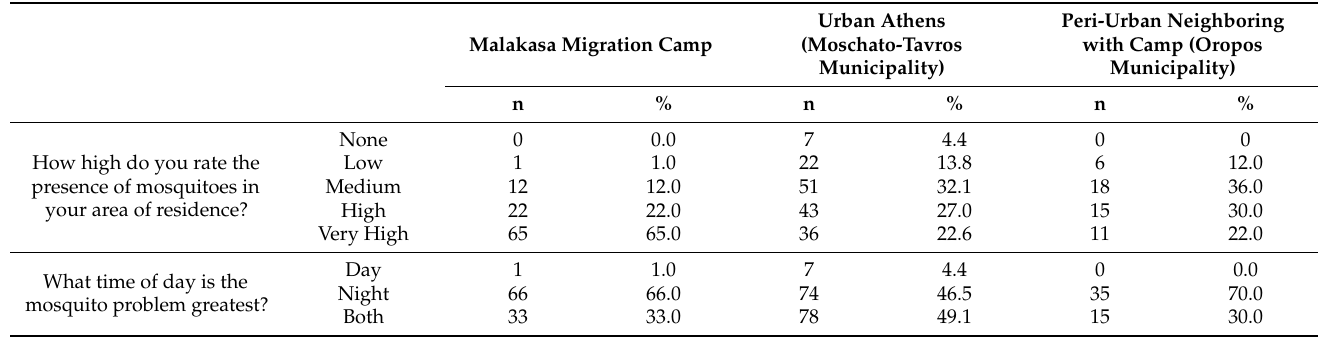
Table 2. Responses to basic questions related to mosquito presence and nuisance.